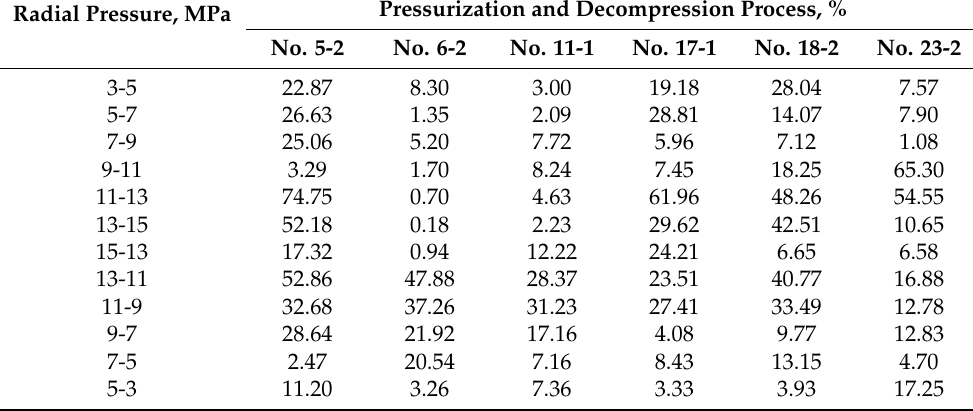
Table 3. The input parameters of finite element model. Parameter Modulus of elasticity/GPa Poisson